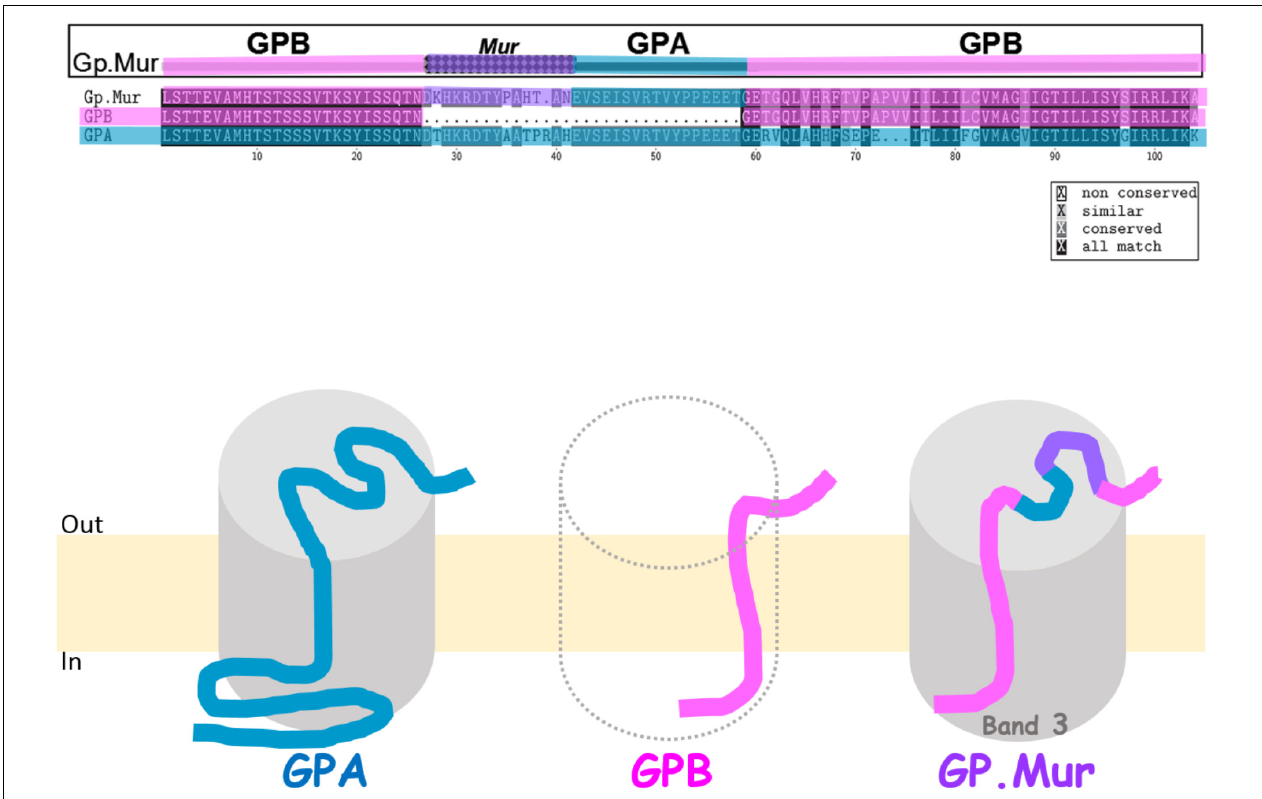
FIGURE 1 | Glycophorin B-A-B hybrid protein GP.Mur interacts with band 3. (Top) Protein sequence alignment of GPA, GPB, and GP.Mur, which was first published in Blood (Hsu et al., 2009), is modified here with color coding. The sequences of GPA and GPB are color-coded with blue and pink, respectively. The antigenic Mur peptide at the cross-over region in GP.Mur is color-coded purple. The configuration of glycophorin B-A-B is revealed by the combination of pink-(purple)-blue-pink colors. (Bottom) GPA, GPB, and GP.Mur are homologous membrane proteins, each with a single transmembrane span. Their N -terminal sequences are located extracellular, with heavy glycosylation (not shown); their C -terminal sequences are intracellular. Both GPA and GP.Mur interact with band 3 (gray cylinder), and GPB does